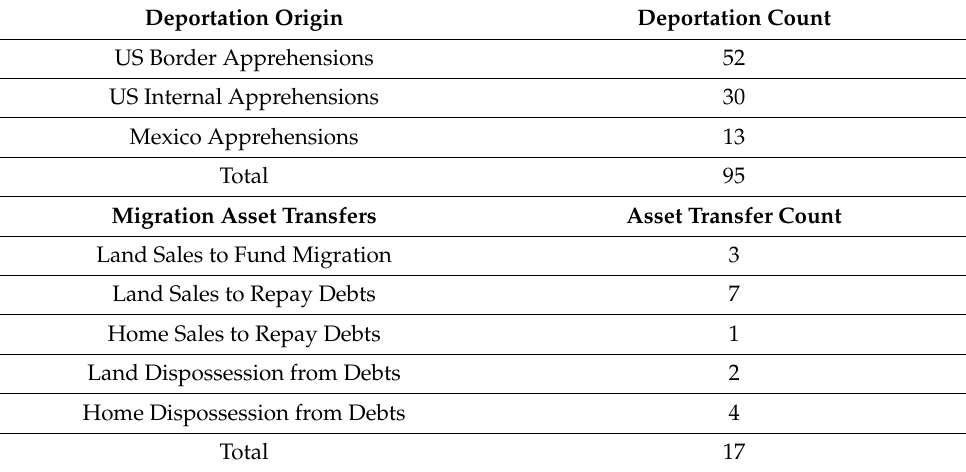
Table 2. Deportations and Migration Asset